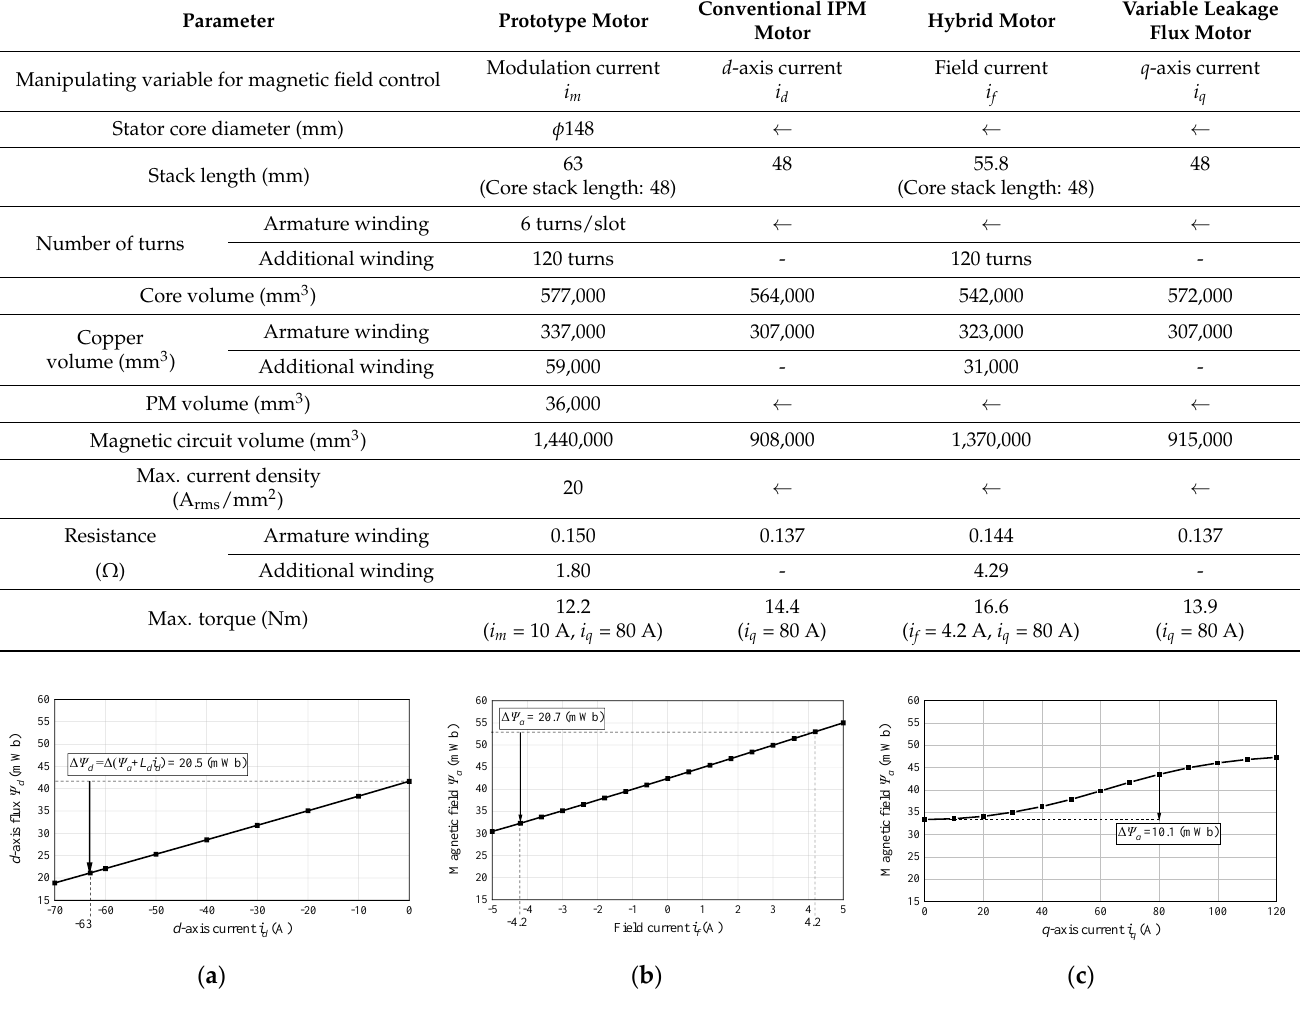
Figure 19. Relationship between magnetic field and variable for magnetic field control: ( a ) conven- tional IPM motor with field weakening control; ( b ) hybrid motor; ( c ) variable leakage flux motor. Table 5. Comparison results of magnetic field control performance.